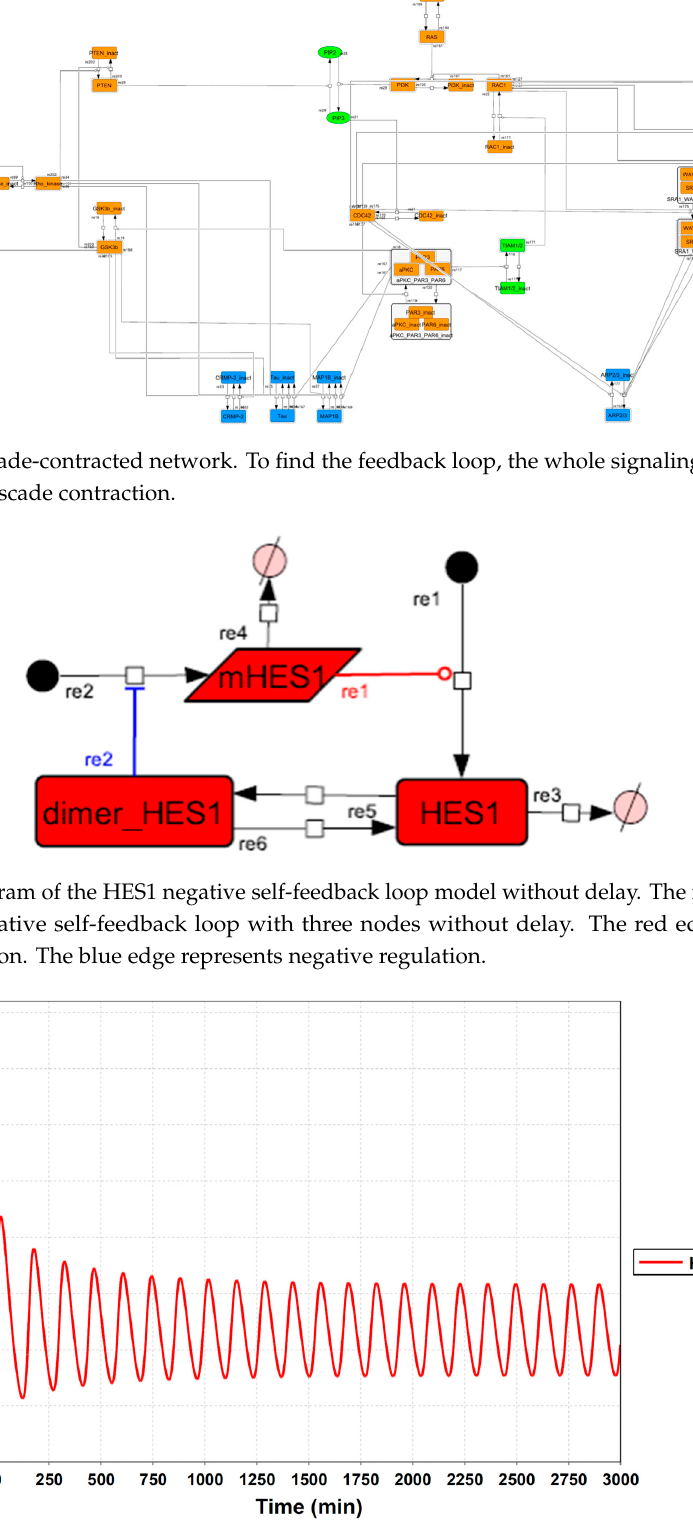
Figure A3. Simulation result of the HES1-loop model. The model could simulate the oscillatory state with a period of almost 2 hours. The following parameters were used: k3 = 0.00129, k3r = 0.0232, kg2 = 4.25, nmre1s9 = 5, kSmre1s9 = 0.00228, kg1 = 3.24, ks3d = 0.0258, and ks2d =